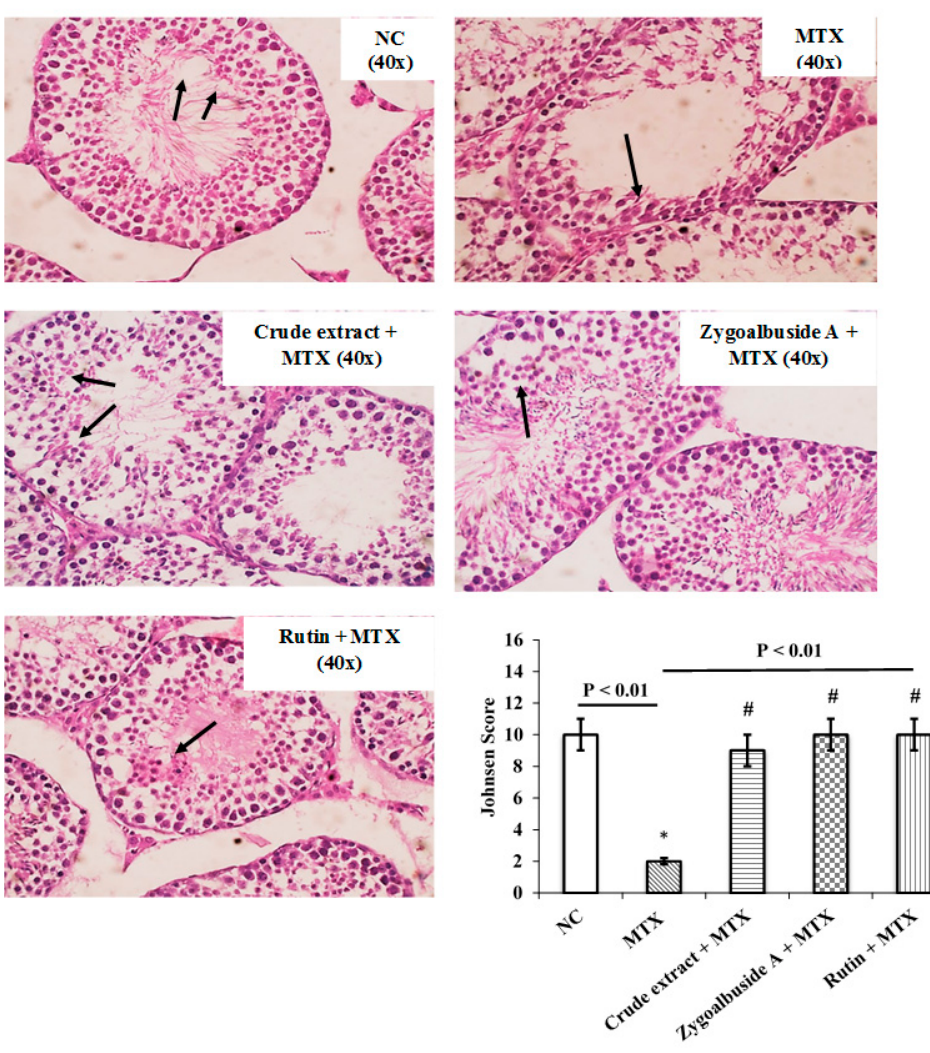
Figure 6. Representative photomicrographs of testis from control and experimentally treated mice. Testicular tissue sections stained with hematoxylin and eosin (40 × ) and scored by Johnsen. The normal control group (NC) showed complete spermatogenesis (black arrow) in all tubules, up to the sperm count (score 10). In the MTX group, some tubules are hyalinized, while other tubules show a marked reduction in spermatogenesis with few spermatocytes (black arrows) (score 2). The Crude extract + MTX group showed tubules with complete spermatogenesis (black arrows) and slightly impaired spermatogenic cells (score 9). The Zygo-albuside A + MTX group showed the most pronounced effect; complete spermatogenesis is evident in all tubules up to spermatids (black arrow) (score 10). The Rutin + MTX group also showed complete spermatogenesis in all tubules, up to the spermatids (black arrow) (score 10). Scores are expressed as mean ± SD (n = 8). Statistical analysis was performed by one-way analysis ANOVA followed by Tukey’s post hoc test. A statistically sig- nificant difference was assumed at p < 0.01 and marked with * vs. NC; # vs. MTX. 3. Discussion Chemotherapeutic drugs have always been associated with persistent azoospermia and infertility in men. MTX can damage testicular tubules, reduce sperm count, and cause genetic abnormalities [96]. Consistent with previous studies, the present study found that a single i.p . dose of 20 mg/kg MTX can cause testicular damage. In this context, great at- tention should be paid to these side effects, and new natural products should be sought to counteract MTX-induced testicular damage.